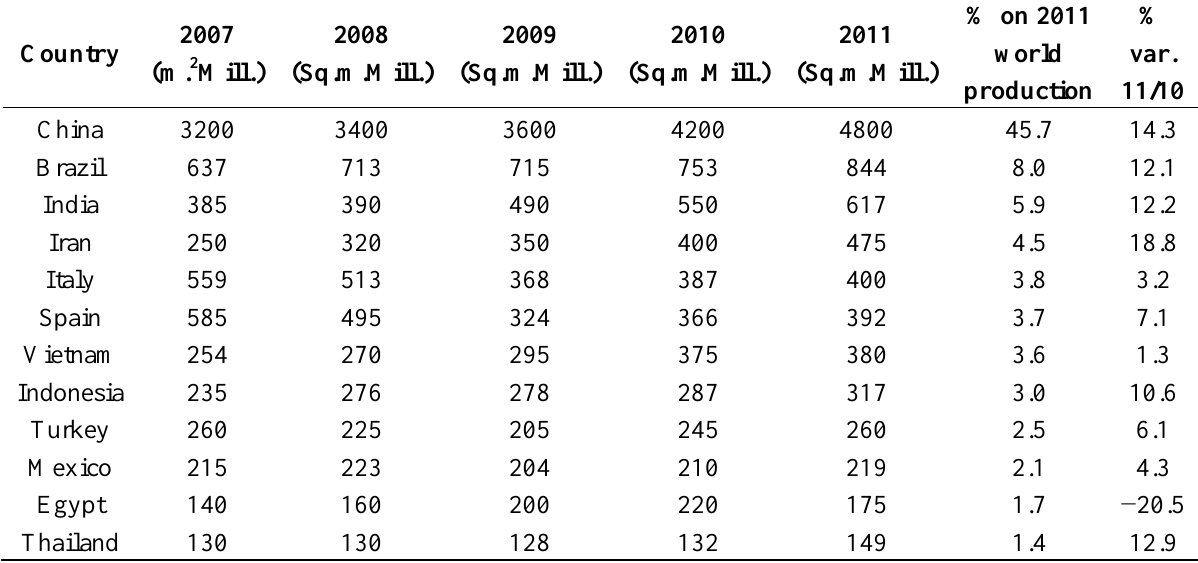
Table 1. Top ceramic tile manufacturing countries, 2007–2011